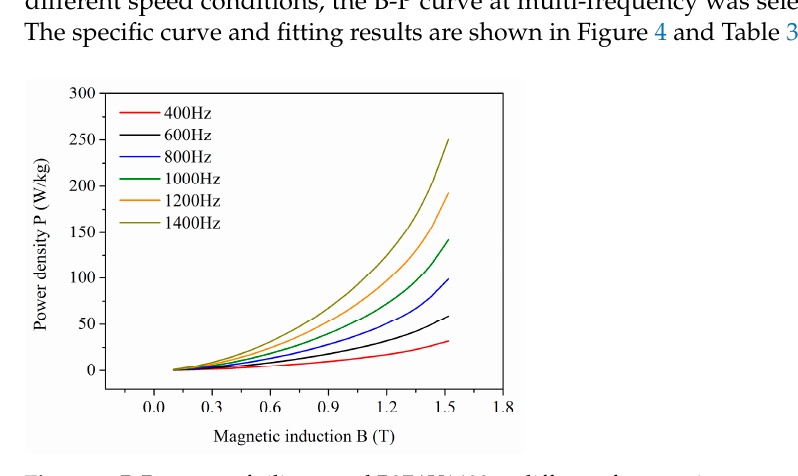
Figure 4. B-P curves of silicon steel B27AV1400 at different frequencies. Table 3. Calculation results of iron loss coefficient of silicon steel sheet B27AV1400.